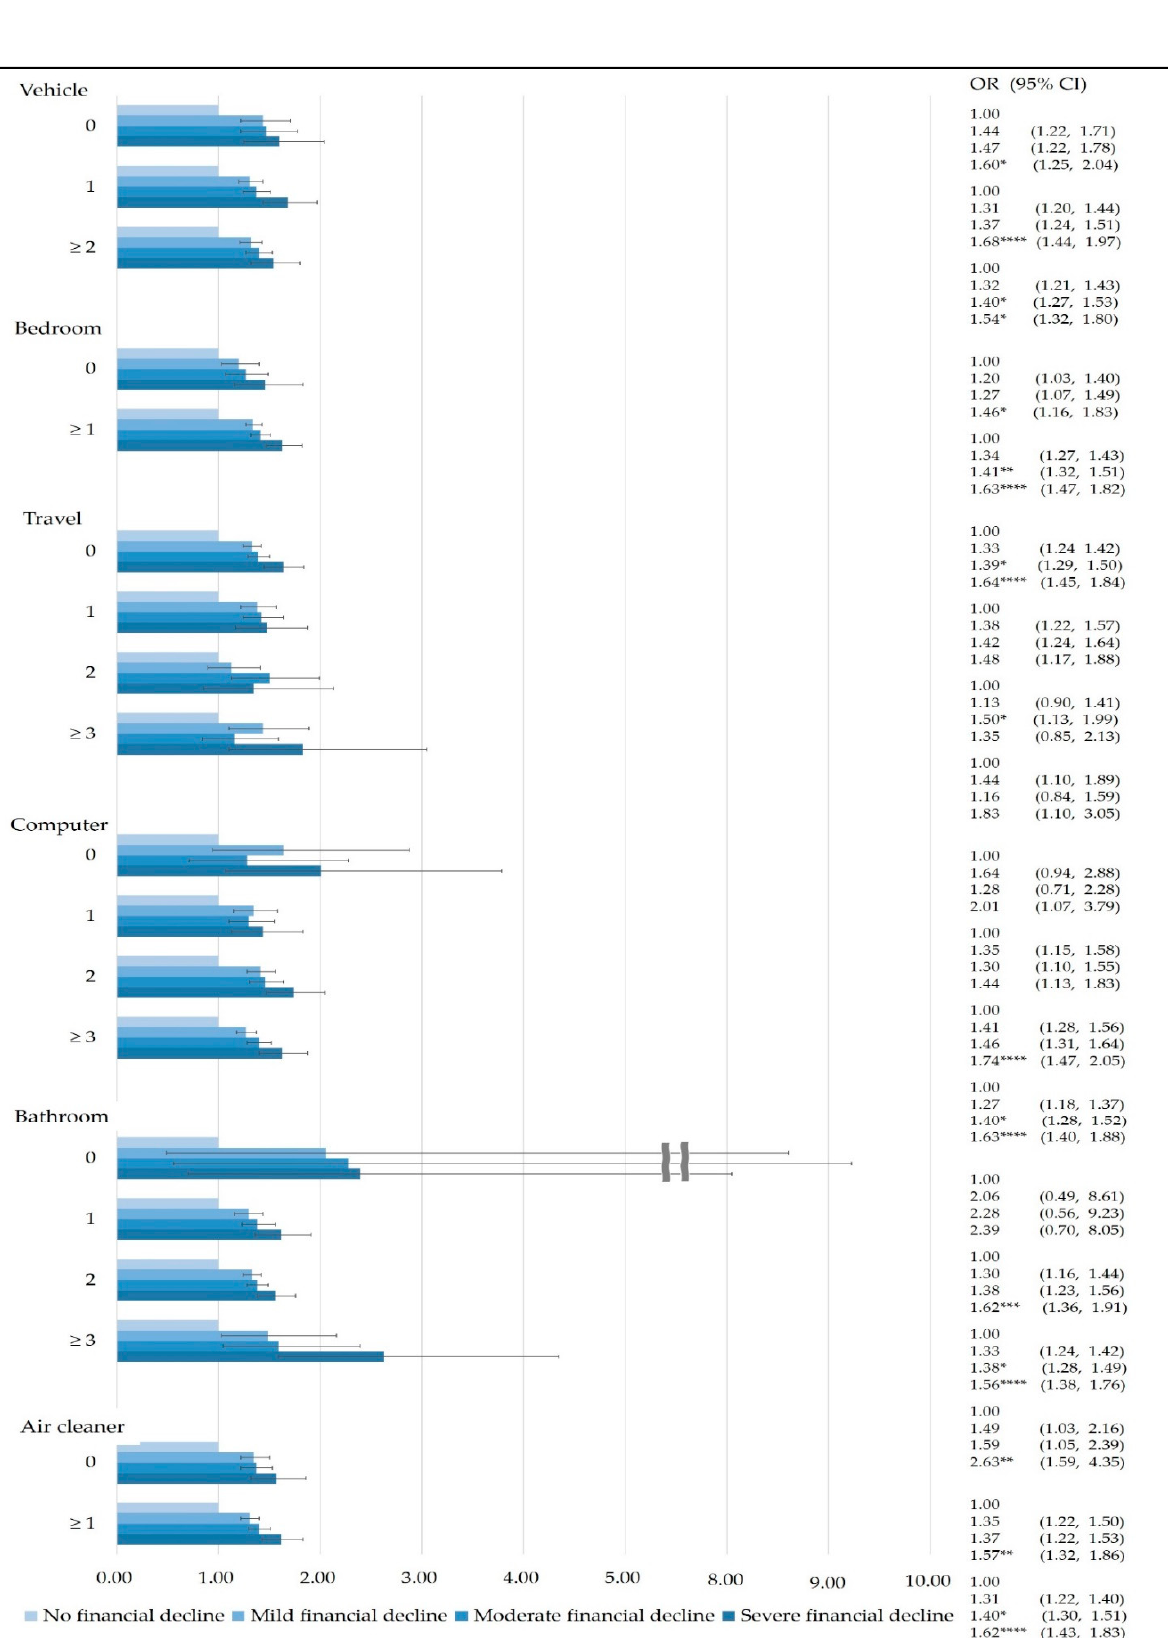
Figure 3. Results of subgroup analysis stratified by family affluence questions (The risk of smartphone dependency due household financial decline caused by COVID-19 was analyzed by each item on the family affluence scale. Reference group: No financial decline. *: p ≤ 0.05, **: p ≤ 0.01, ***: p ≤ 0.001, ****: p ≤ 0.0001).